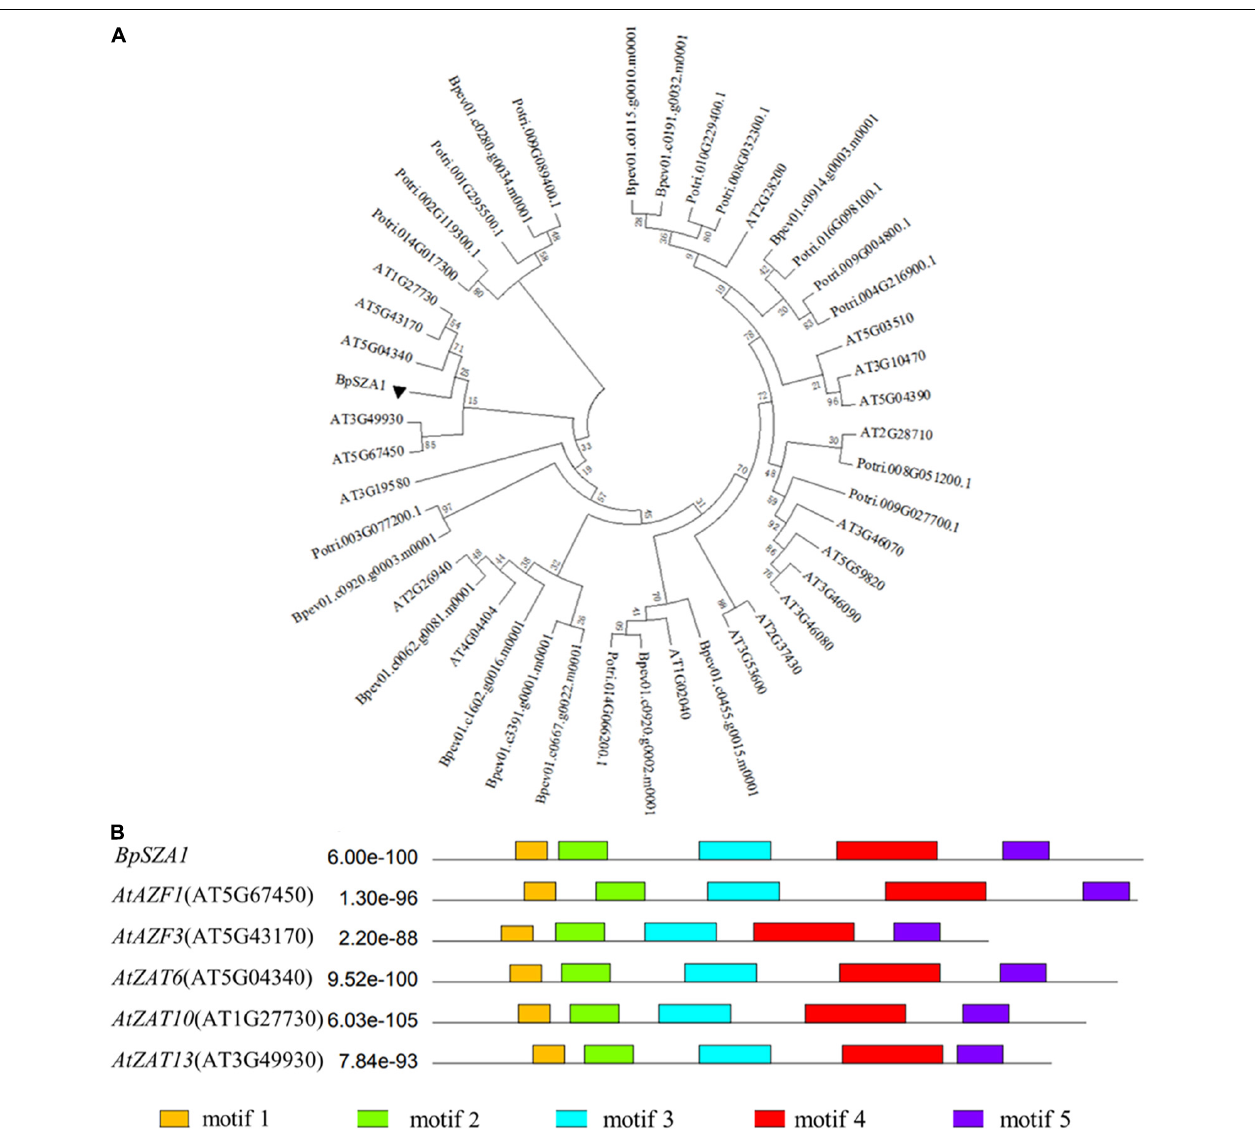
FIGURE 1 | Phylogenetic and bioinformatics analyses of BpSZA1 from Betula platyphylla . (A) Phylogenetic analysis of BpSZA1 and 45 members of the C2H2-type transcription factor from Arabidopsis thaliana (20 members, prefixed with At), Populus trichocarpa (13 members, prefixed with Potri), and Betula pendula Roth (12 members, prefixed with Bpev) by using the maximum likelihood method. (B) Conserved protein motifs of BpSZA1 and five C2H2-type transcription factor C1-2i subfamily members in Arabidopsis thaliana